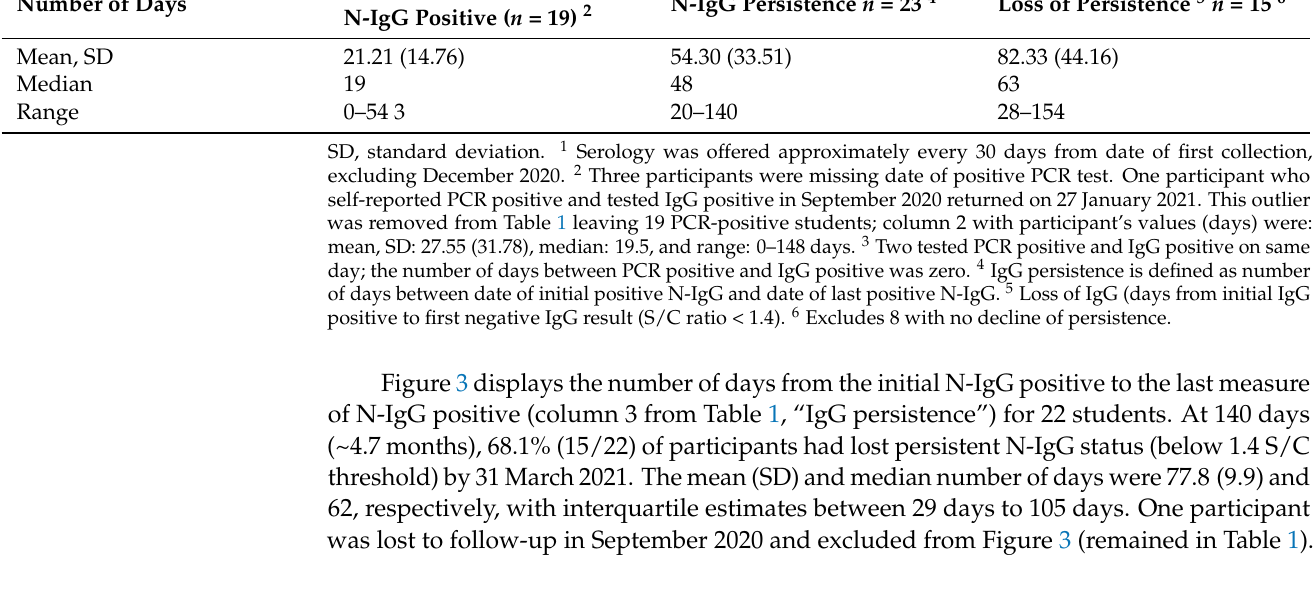
Table 1. Number of days of persistence and loss for N-IgG seropositivity in 23 young adults with greater than one positive N-IgG result, 1 September 2020 through 31 March 2021 1 .